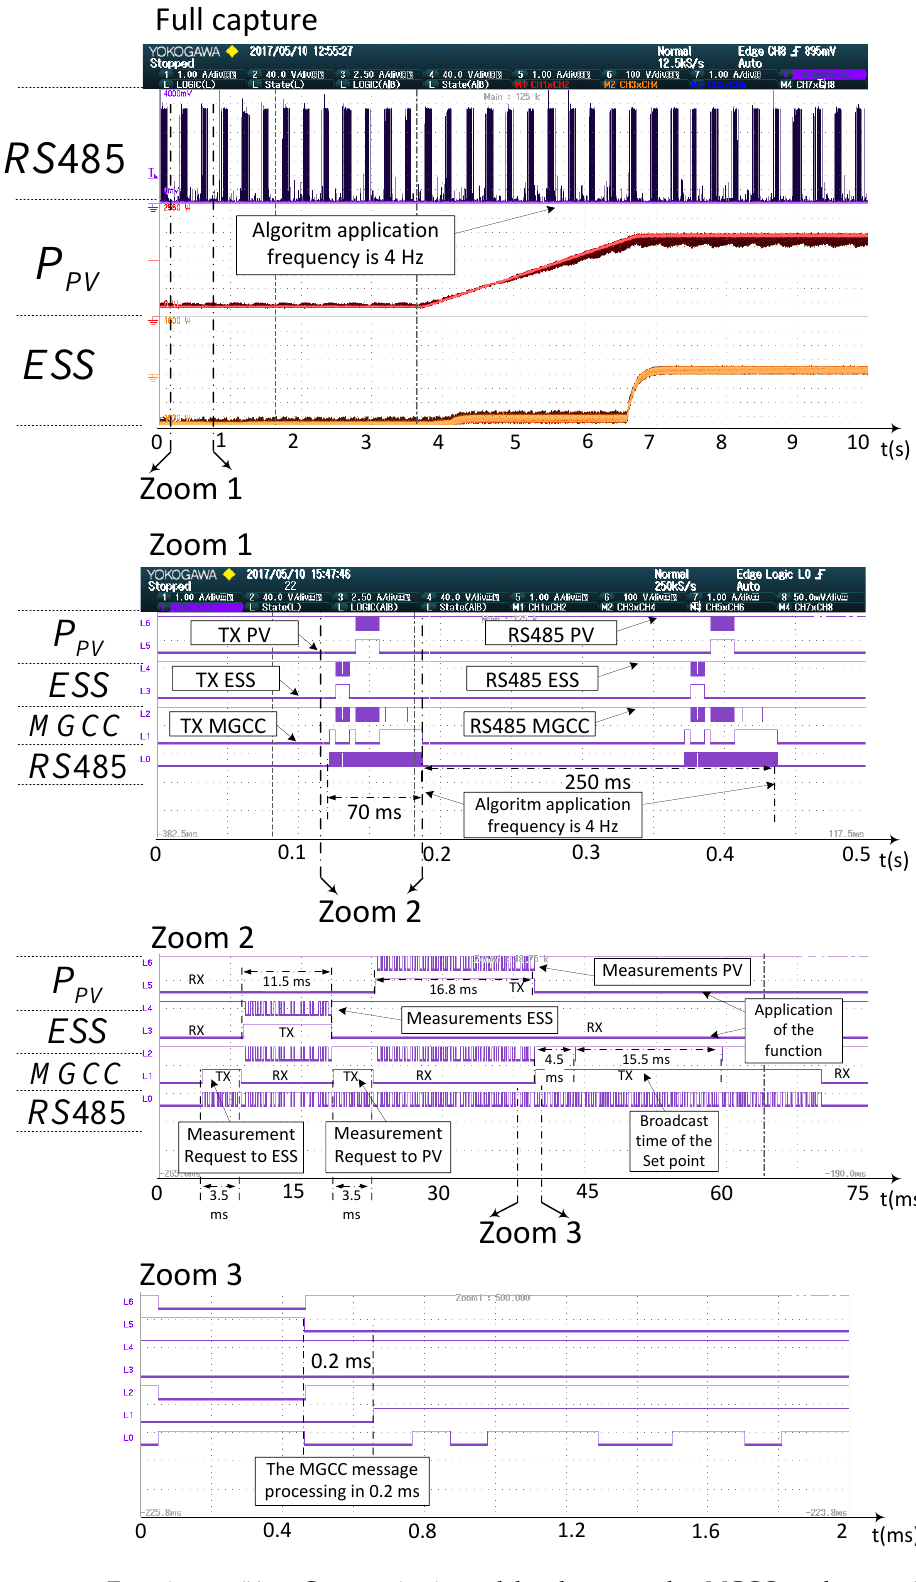
Figure 12. Experiment #4. Communications delay between the MGCC and two of the microgrid elements.